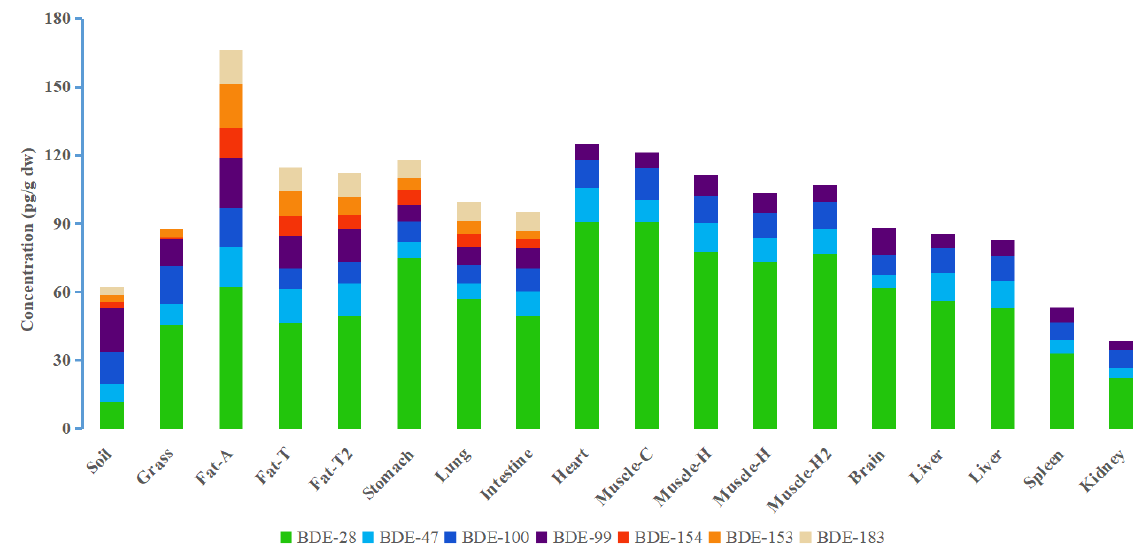
Figure 1. Polybrominated diphenyl ether concentrations in different tissues or organs from a sheep raised in a grassland area. Notes: Fat-A = abdominal fat, Fat-T = tail fat, Fat-T2 = tail fat of the second sheep, Muscle-C = chest muscle, Muscle-H = hind leg muscle, Muscle-H2 = hind leg muscle of the second sheep.